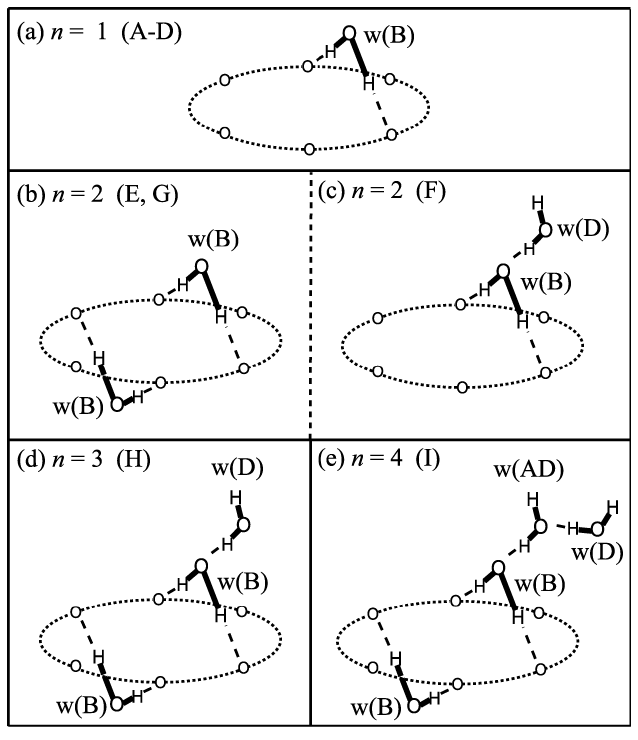
Figure 10. Geometric features deduced from the analysis of the IR-UV DR spectra in the OH stretching region of species A-I of the B18C6-(H for bidentate and singly H-bonded H as w(AD) takes part in H-bonding as both acceptor and donor. Figure adapted from Reference